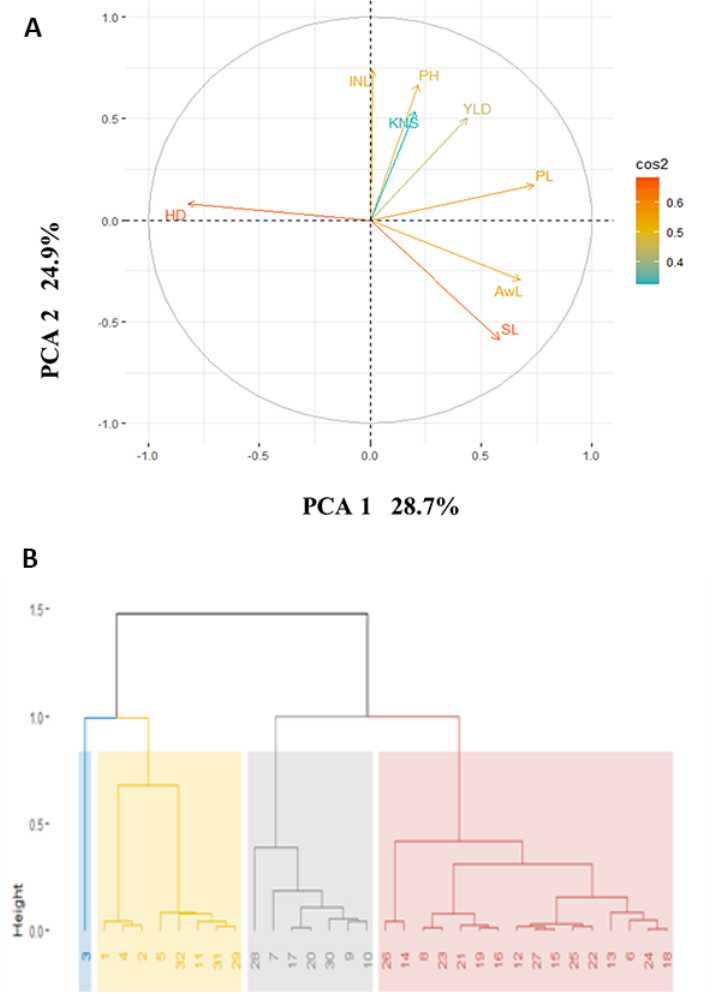
Figure 1 Principal component ( A ) and hierarchical cluster ( B ) analyses. The first two principal components, PCA1 and PCA2, explained 28.7% and 24.9% of the total variation. Days to heading (DH) and spike length (SL) make the major contributions to the total variation. Hierarchical cluster based on the mean values of the studied traits across the three cropping seasons identified clusters of accessions. See the text for explanation of other